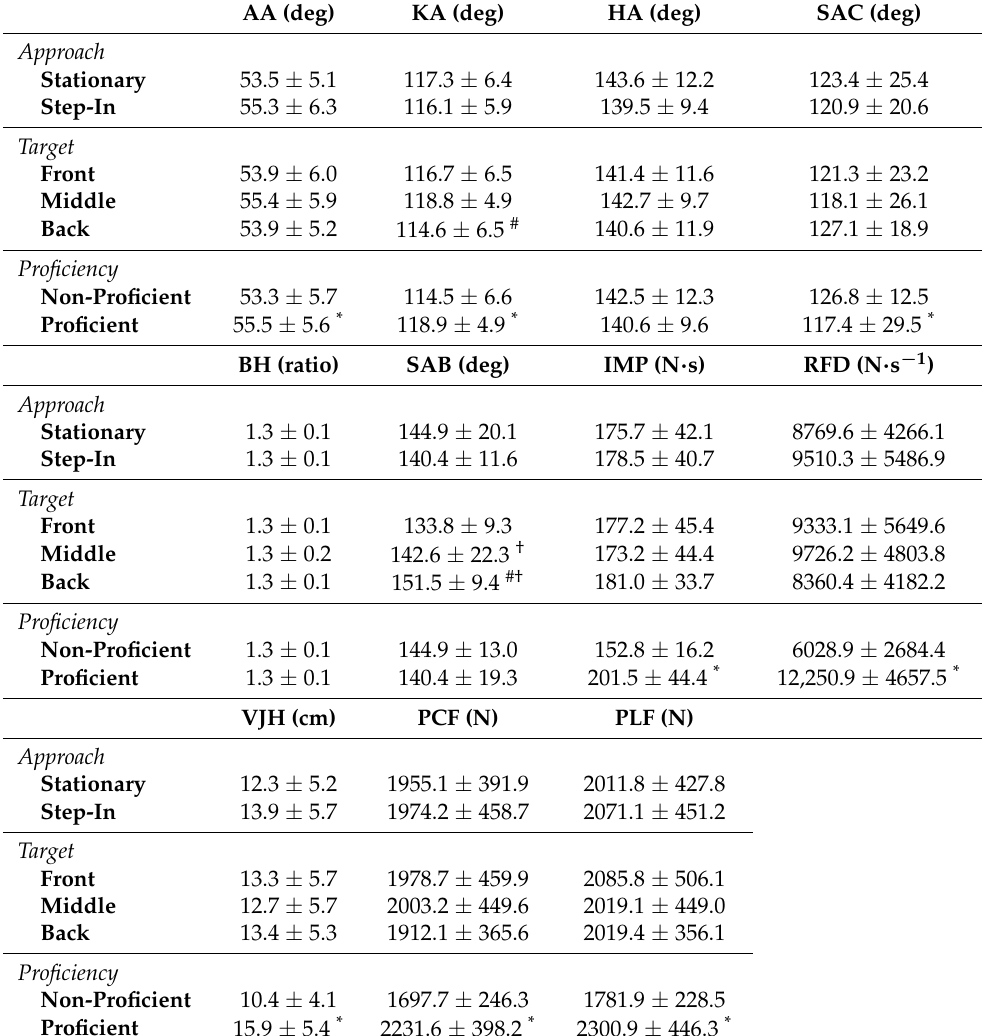
Table 1. Descriptive statistics, mean and standard deviation (x ± SD), for each kinetic and kinematic variable examined in the present investigation. KA = knee angle; HA = hip angle; SAC = shoulder angle at the initial concentric phase of setting motion; AA = ankle angle; BH = ball height; SAB = shoulder angle at the initial contact with the ball; PCF = peak concentric force; PLF = peak landing force; IMP = impulse; RFD = rate of force development; VJH = vertical jump height. AA (deg) KA (deg) HA (deg) SAC